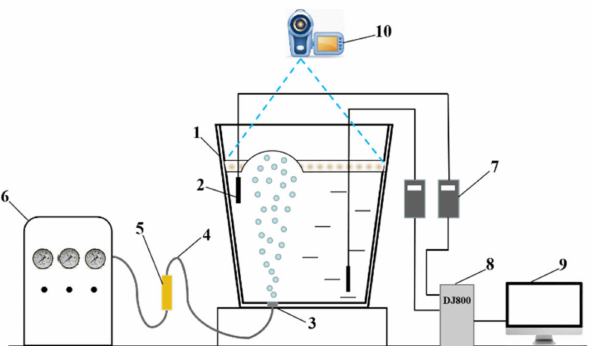
Figure 1. Equipment connection diagram. 1—model; 2—conductivity electrode; 3—porous plug; 4—tube; 5—gas flowmeter; 6—air compressor; 7—conductivity meter; 8—multifunction monitoring system (DJ800); 9—computer; 10—camera.